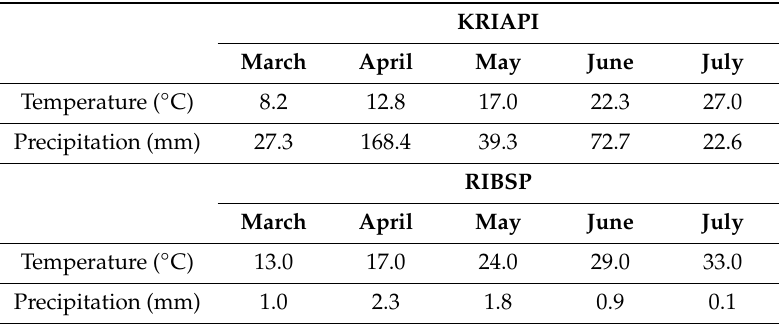
Table 2. Meteorological data on average temperature and precipitations during the vegetation period in the fields of Research Institute of Biological Safety Problems (RIBSP, southern Kazakhstan) and Kazakh Research Institute of Agriculture and Plant Industry (KRIAPI, southeastern